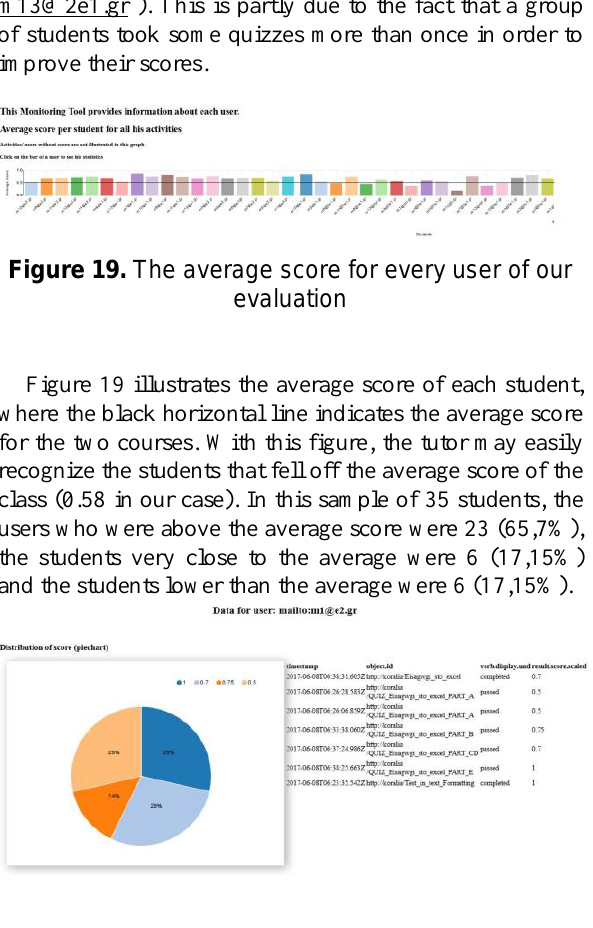
Figure 20. The score for each statement of the user